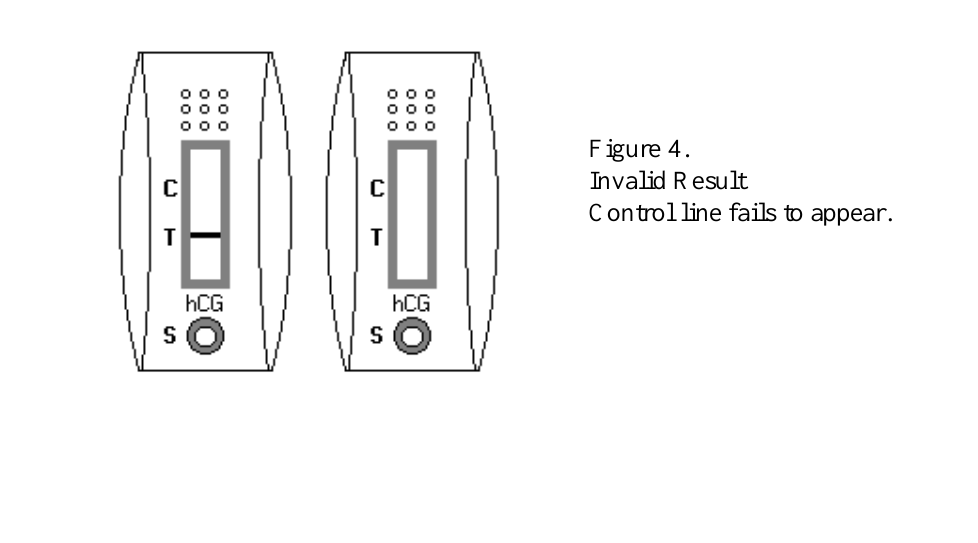
Figure 3. Negative Result One red line appears in the control region (C). No apparent red or pink line appears in the test region.